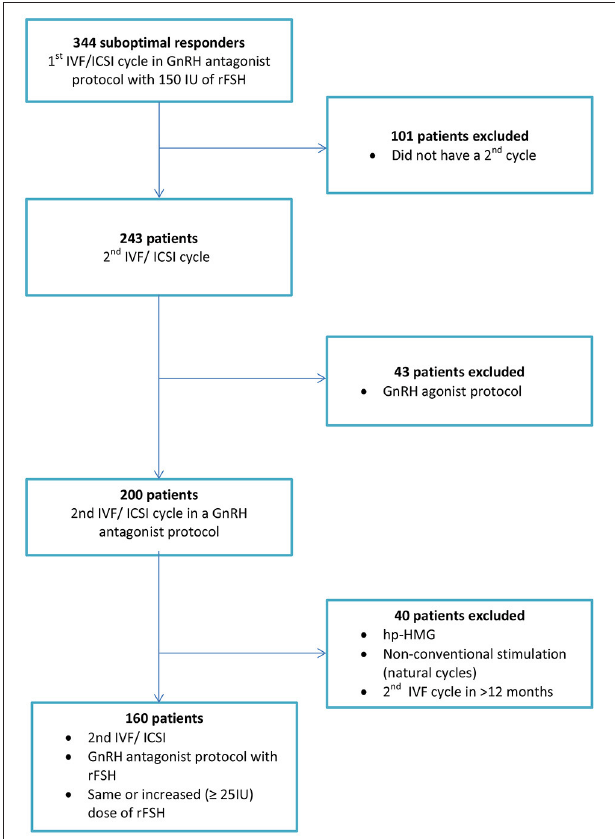
FIGURE 1 | Flowchart of the included